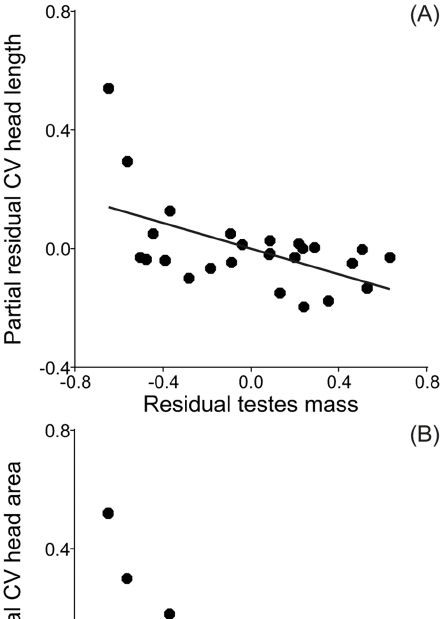
Figure 2. Relationships between residual testes mass and coefficients of variation (CV) for dimensions of several sperm components. (A) CV head length, (B) CV head area, (C) CV total flagellum length, and (D) CV total sperm